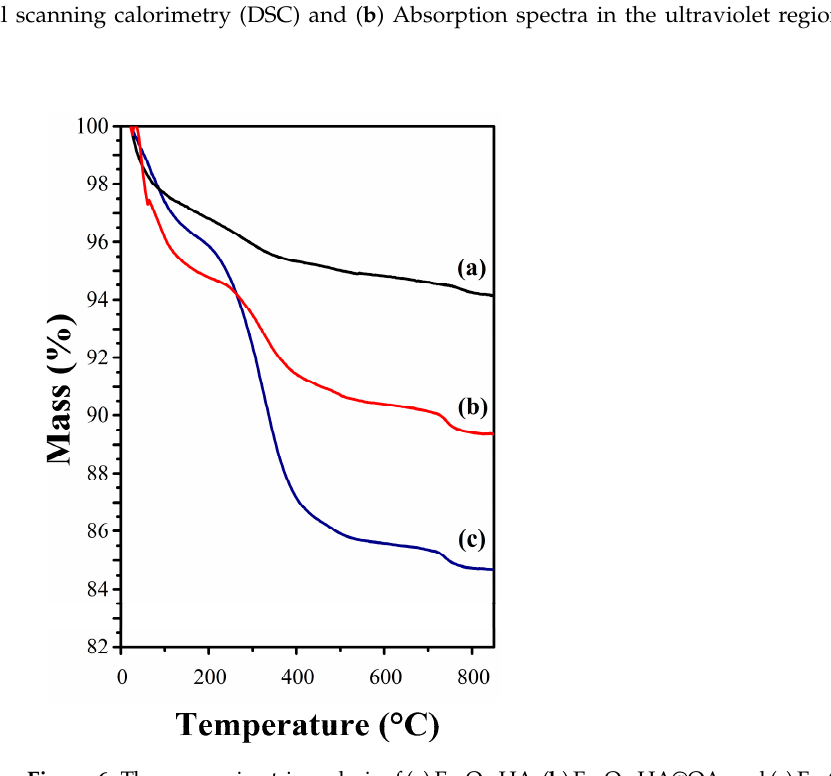
Figure 6. Thermogravimetric a nalysis of ( a ) Fe 3 O 4 -HA, ( b ) Fe 3 O 4 -HA@OA, and ( c ) Fe 3 O 4 -HA@OA-